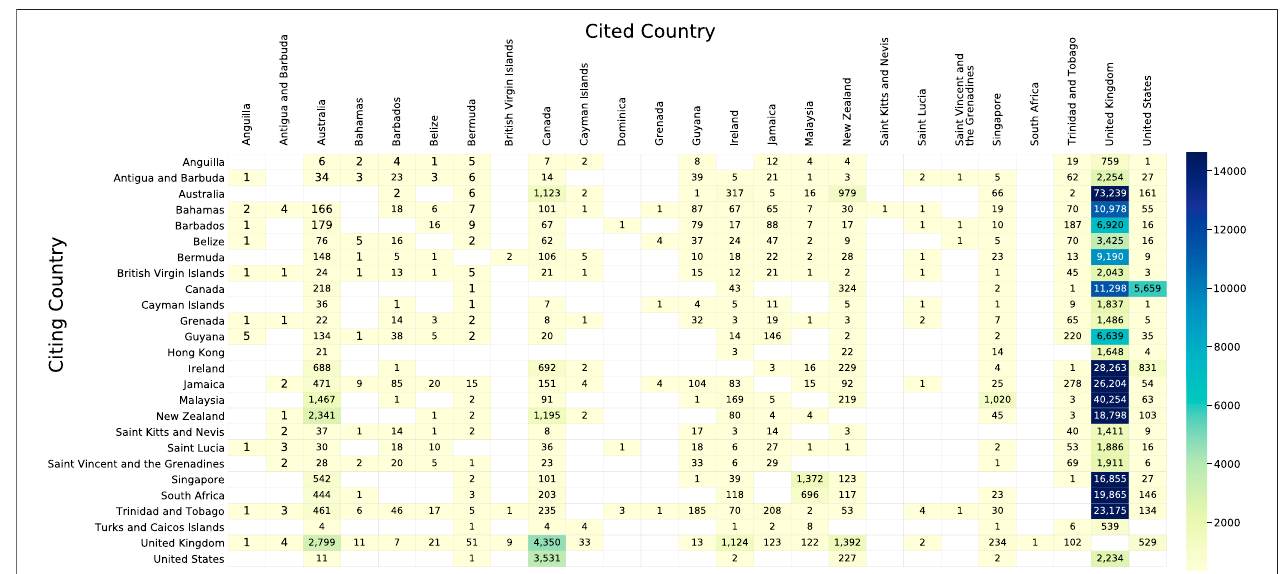
FIGURE11| Heatmapofcitationsbetweencountriesinthecross-jurisdictionalnetwork.Citingcountriesareshowontheleftaxisandcitingcountriesareshownon the top